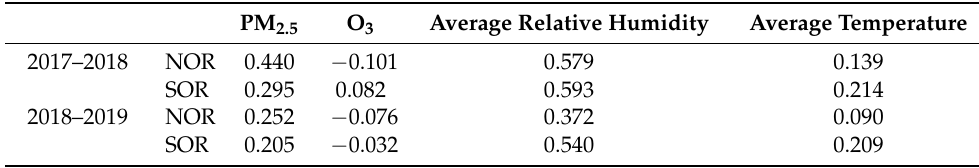
Table 4. Kendall’s tau coefficient between NOR, SOR, and the temperature, relative humidity concentration of PM 2.5 , O